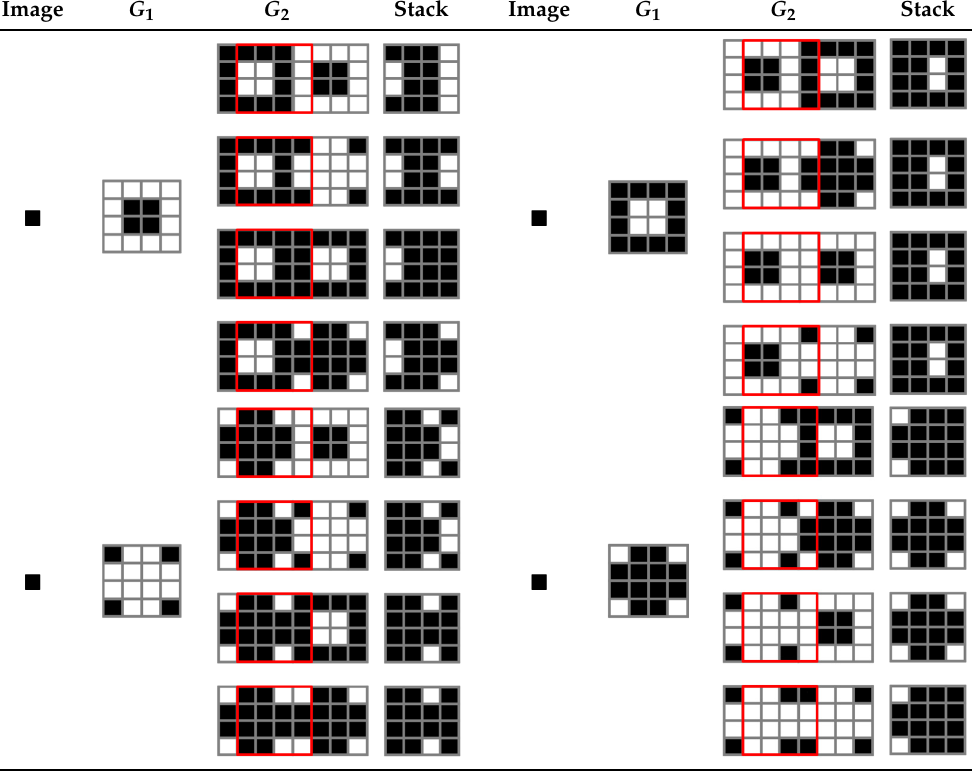
Figure 3. Stacked image with one pixel right shifted. Table 5. The designed patterns for n = 5. Table 5. The designed patterns for n = 5.